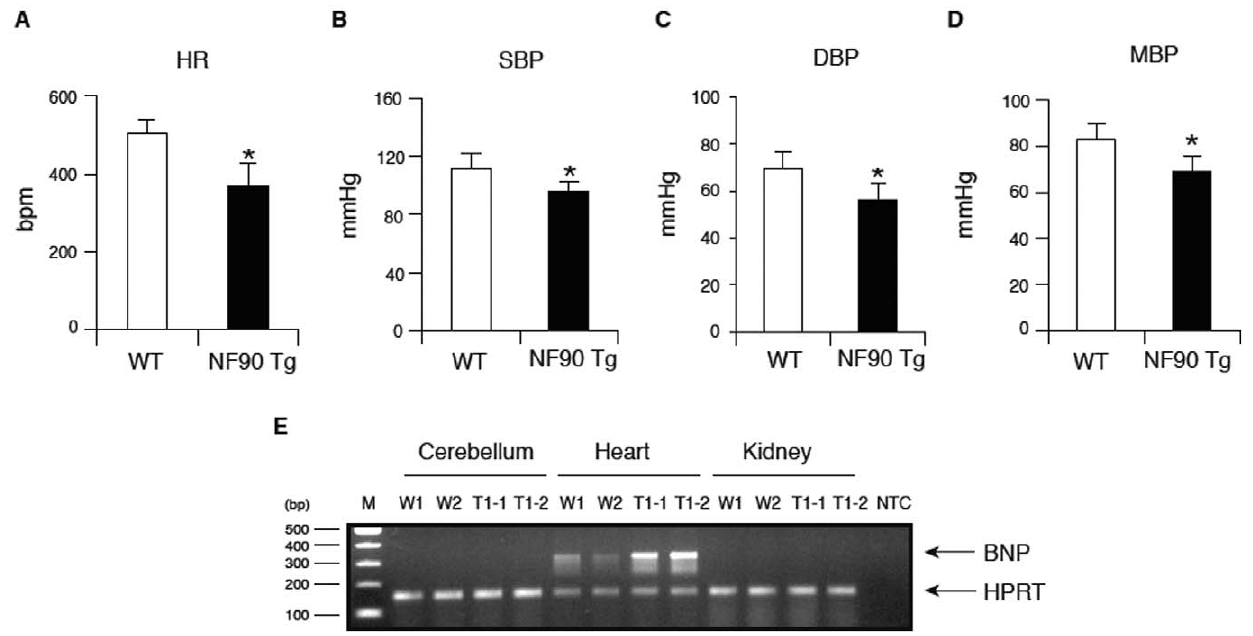
Figure 3. NF90 Tg mice display heart failure. (A to E) Measurement of heart rate, blood pressure (BP) and brain natriuretic peptide (BNP) of WT and NF90 Tg mice (line TG1) at 14 weeks to 19 weeks of age. Heart rate and BP of mice were measured by a programmable sphygmomanometer using tail-cuff method. (A) HR, heart rate; (B) SBP, systolic blood pressure; (C) DBP, diastolic blood pressure; (D) MBP, mean blood pressure. All data are expressed as means 6 SD (n=7 per group). *, p , 0.01 relative to WT by a two-tailed Student’s t test. (E) The expression of BNP in NF90 Tg mice. Total RNAs isolated from cerebellum, heart and kidney of WT and NF90 Tg mice (line TG1) were analyzed by RT-PCR with specific primers for BNP or HPRT. HPRT was used as an internal control. W-1 and W-2, wild-type; T-1 and -2, NF90 Tg mice (line TG1).